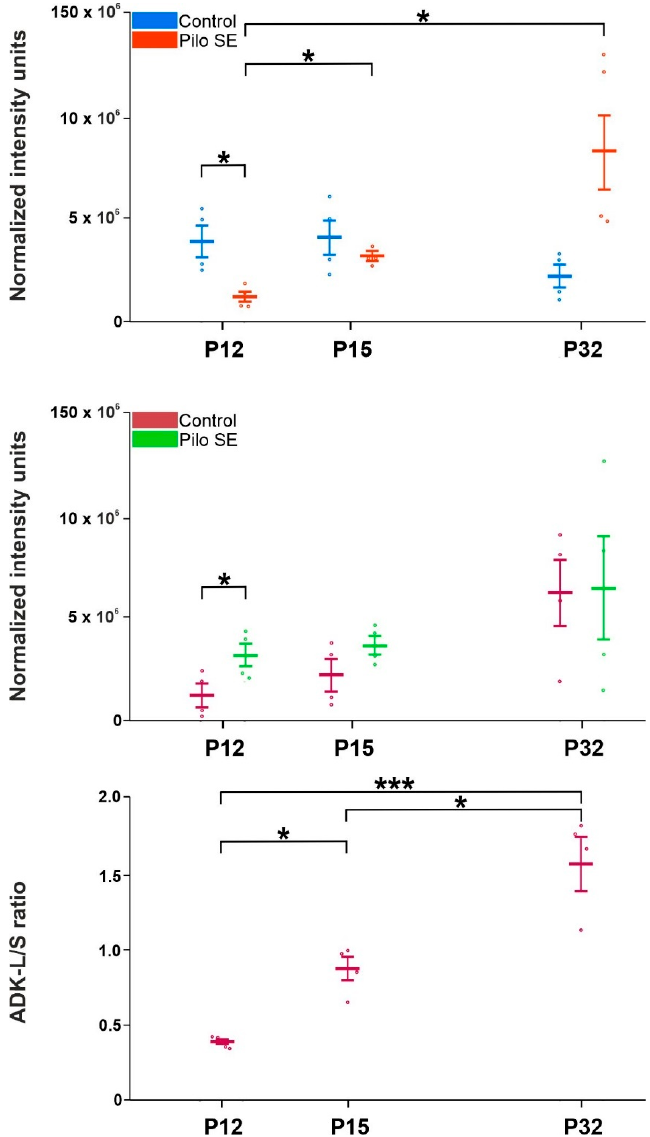
Figure 4. Analysis of ADK isoforms in control and LiCl/pilocarpine SE rats, ADK-L and ADK-S (mean gray value + SEM), in three age groups. From top to bottom: ADK-L in LiCl/pilocarpine SE, ADK-S in LiCl/pilocarpine SE, ADK-L/-S ratio in LiCl/pilocarpine SE. Abscissae from left to right: 12-, 15-, and 32-day-old rats in controls and LiCl/pilocarpine SE (see inset); ordinates: normalized intensity units or ratio (see inset). One or three asterisks denote a significant difference for * p < 0.01 or *** p < 0.001, respectively (details, see inset).